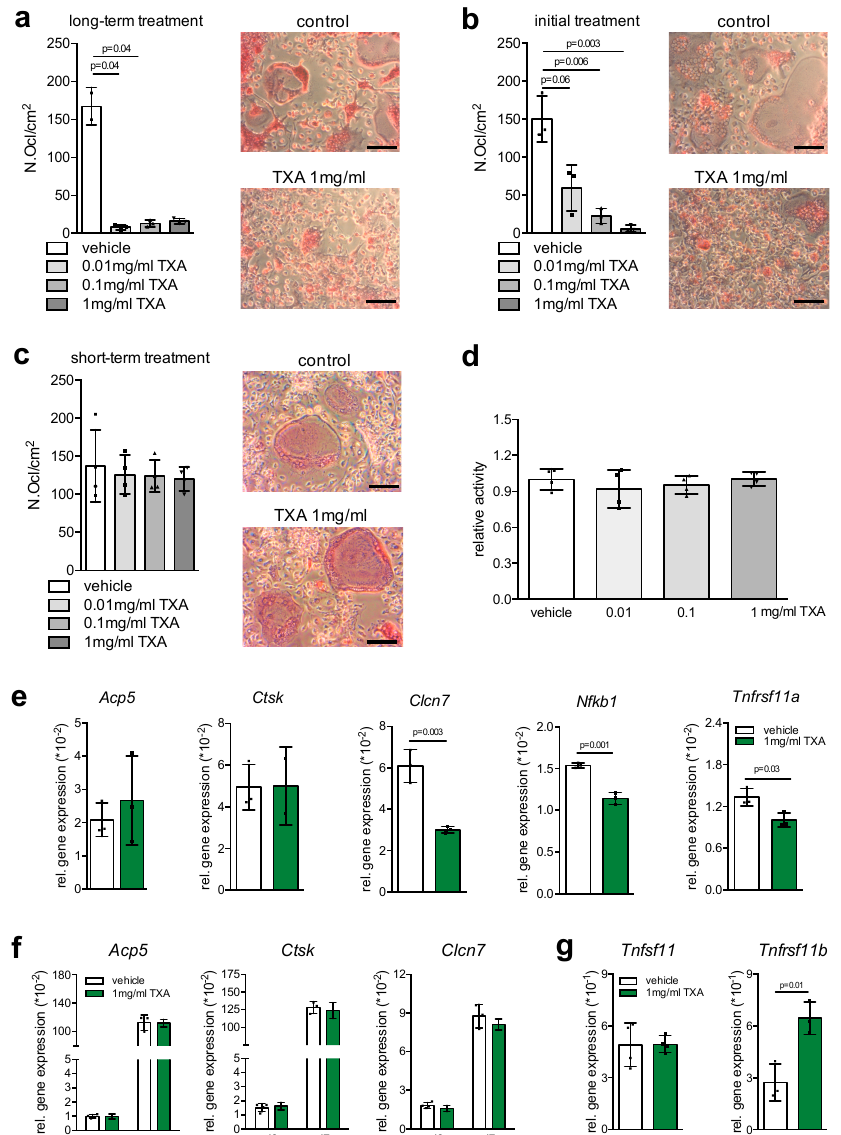
Figure 4. Inhibition of early osteoclastogenesis through TXA. ( a ) TRAP activity staining of WT bone marrow cells at day 7 of differentiation, cultured in the presence of M-CSF and RANKL and continuous exposure to vehicle or TXA at the indicated concentrations. Scale bars = 50 µ m. The quantification of osteoclast numbers per viewing field is depicted on the left (Ocl.N./VF). ( b ) TRAP activity staining of WT bone marrow cells at day 7 of differentiation, cultured in the presence of M-CSF and RANKL, and exposure to vehicle or TXA at the indicated concentrations only at day 1 of osteoclast differentiation. The quantification of osteoclast numbers per viewing field is depicted on the left (Ocl.N./VF). ( c ) TRAP activity staining of WT osteoclasts at day 7 of differentiation, cultured in the presence of M-CSF and RANKL and exposed to vehicle or TXA at the indicated concentrations for 24 h. ( d ) MTT proliferation assay of WT osteoclasts at day 7 of differentiation stimulated with the indicated concentrations of TXA for 6 h. ( e ) qRT-PCR expression analysis for the indicated genes in bone marrow-derived osteoclasts at day 7, stimulated with TXA (1 mg/mL) during the entire course of cell differentiation. ( f ) qRT-PCR expression analysis for the indicated genes in bone marrow-derived osteoclasts at the indicated stages of cell differentiation, stimulated with TXA (1 mg/mL) for 6 h. ( g ) qRT-PCR expression analysis for the indicated genes in bone marrow-derived osteoclasts at day 5 of differentiation, stimulated with TXA (1 mg/mL) during the entire course of cell differentiation. For ( a – g ), n = 3–4 independent cultures per group were used. Data presented are means ± SD. Gene abbreviations: chloride channel 7 ( Clcn7 ), nuclear factor kappa B subunit 1 ( Nfkb1 ), receptor activator of nf- κ b ( Tnfrsf11a ), tartrate-resistant acid phosphatase ( Acp5 ), cathepsin K ( Ctsk